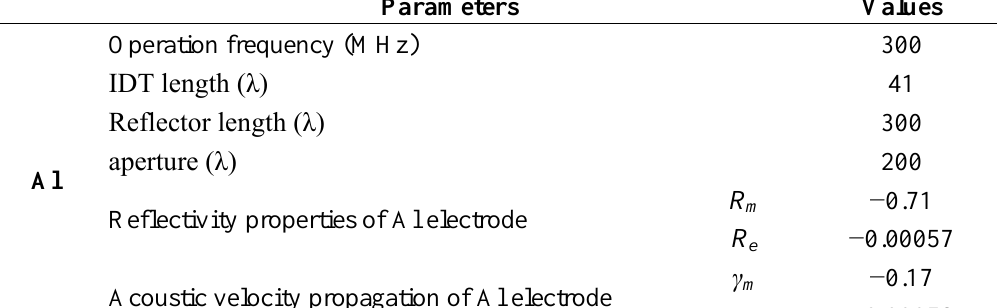
Table 1. Simulation parameters for SAW resonator with Al/Au electrode structure.